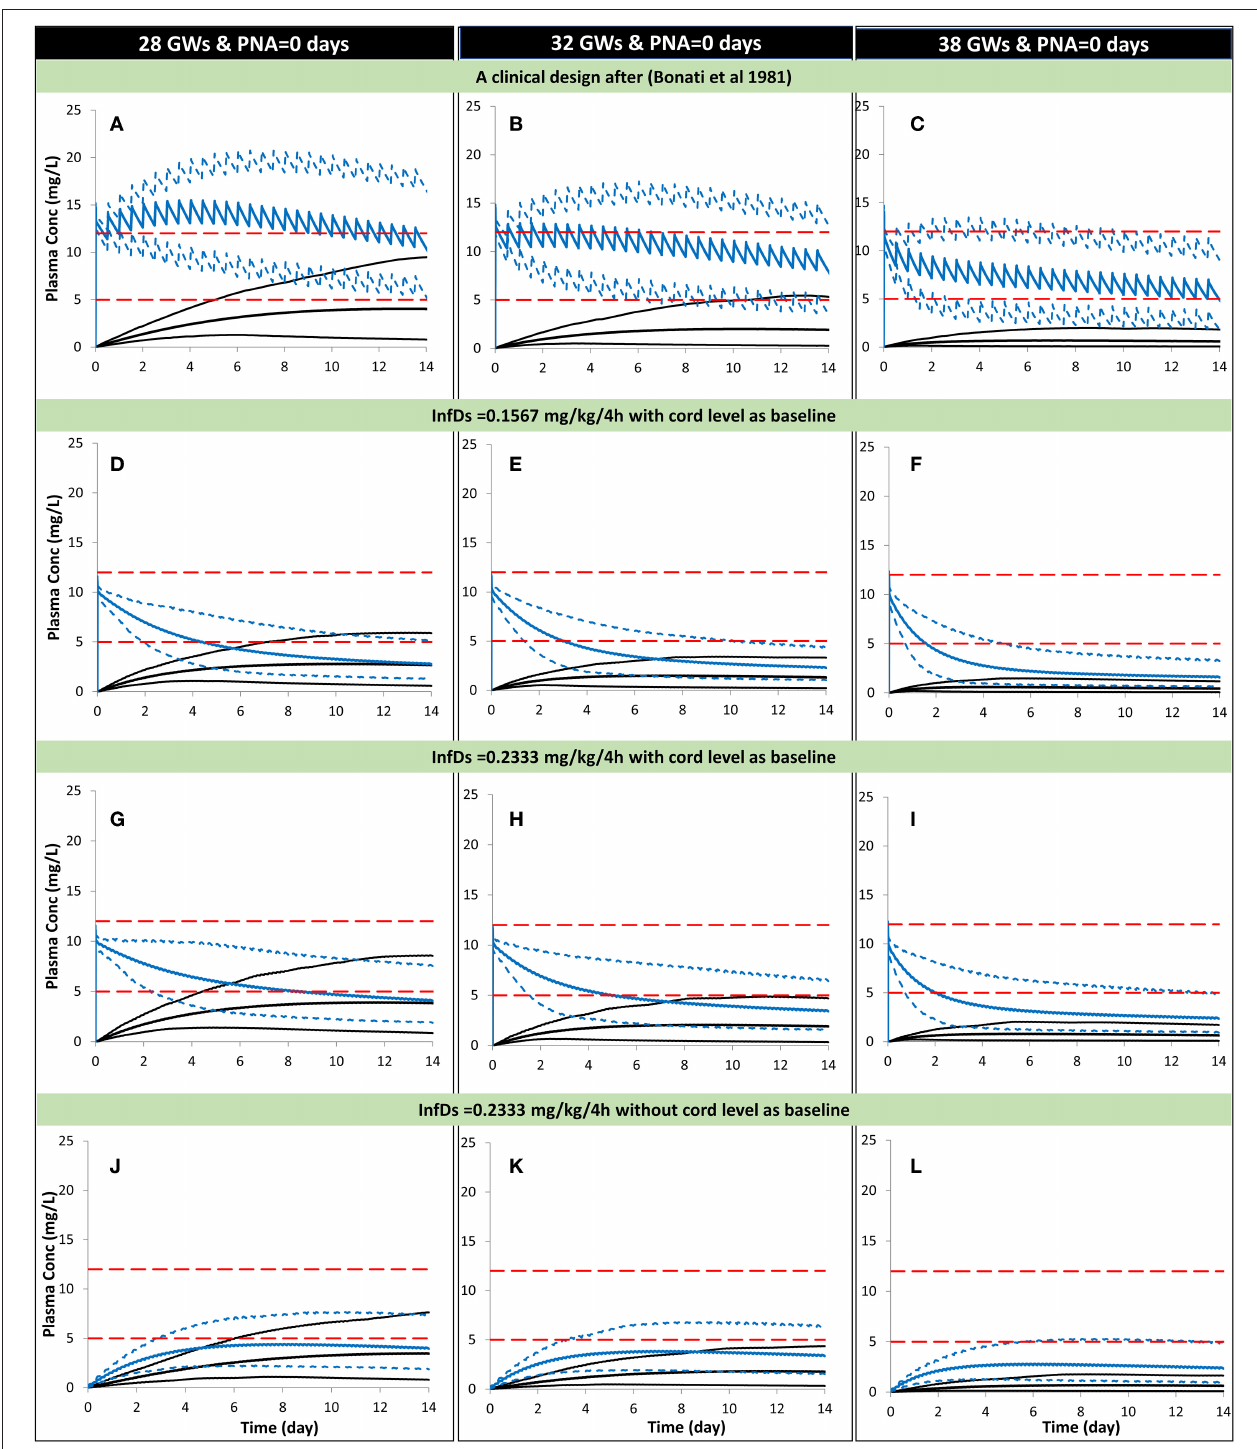
FIGURE 6 | Predicted mean (5th − 95th percentiles) neonatal theophylline (and formed caffeine) concentration during the first 2 weeks of life with different gestational weeks. Predicted scenarios: The first three plots show, respectively, theophylline exposure in neonates at birth using a dosage of 30-min infusion of 5 mg/kg as a loading dose followed by 1 h-infusion of 1.1 mg/kg/12h in 28 (A) , 32 (B) , and 38 (C) GWs according to a clinical study (28). Exposure after oral administration of the calculated theophylline infant dose using milk C avg,ss are shown for 28 (D) , 32 (E) , and 38 (F) GW considering the cord level at birth as a baseline. Exposure after oral administration of the calculated theophylline infant dose using milk C max,ss are shown for 28 (G) , 32 (H) , and 38 (I) GW considering the cord level at birth as a baseline.